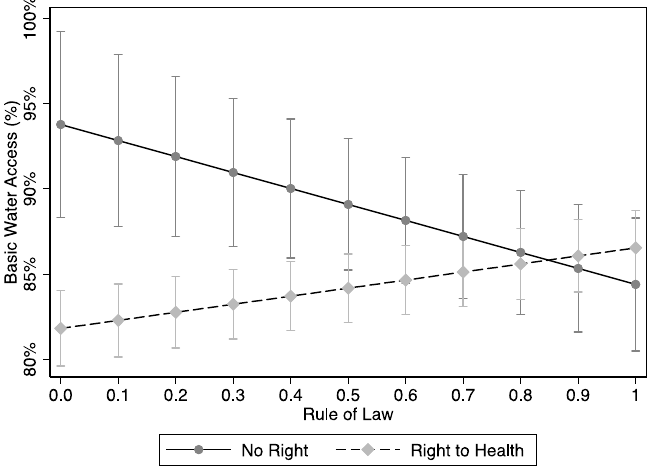
Figure 3. Marginal Effects of Rule of Law and Right to Health on Access.